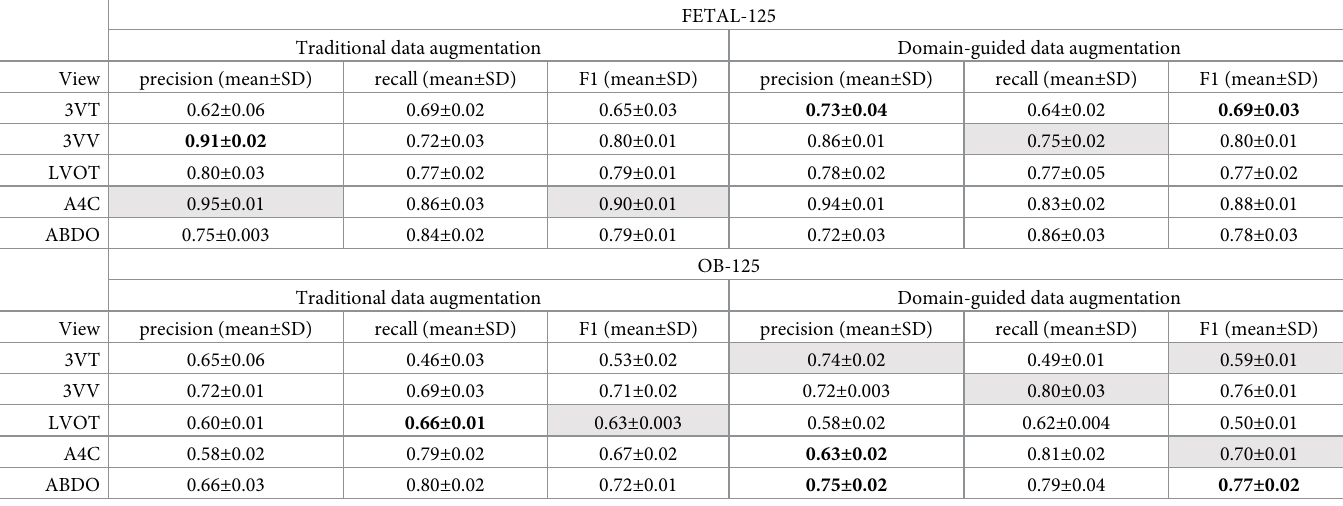
Finally, we examined the number of false-positive views in the OB-125 test set predicted by the models trained with traditional and bespoke data augmentation, respectively. False-posi- tive views are defined as in [1] as images that are labeled as NT, but are predicted by the model as one of the five views of interest (Fig 2b). Bespoke data augmentation resulted in a model Table 6. Per-class recall values for results in Table